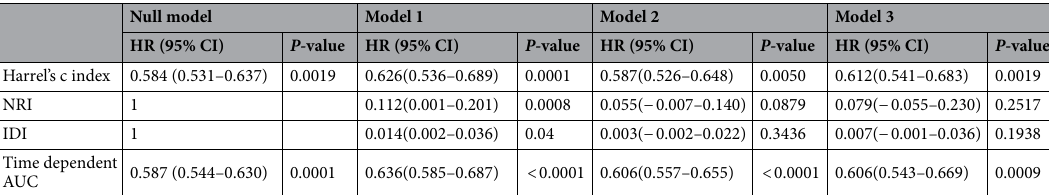
Table 3. Evaluation of multivariate Cox proportional hazard model using Harrel’s c -index, NRI, IDI, and time-dependent AUC for RFS. AUC, area under the curve; CI, confidence interval; HR, hazard ratio; IDI, integrated discrimination improvement; NRI, net reclassification index; RFS, recurrence-free survival. *Null model: including age. **Model 1: Null model + 22C3. ***Model 2: Null model + SP142. ****Model 3: Null model +